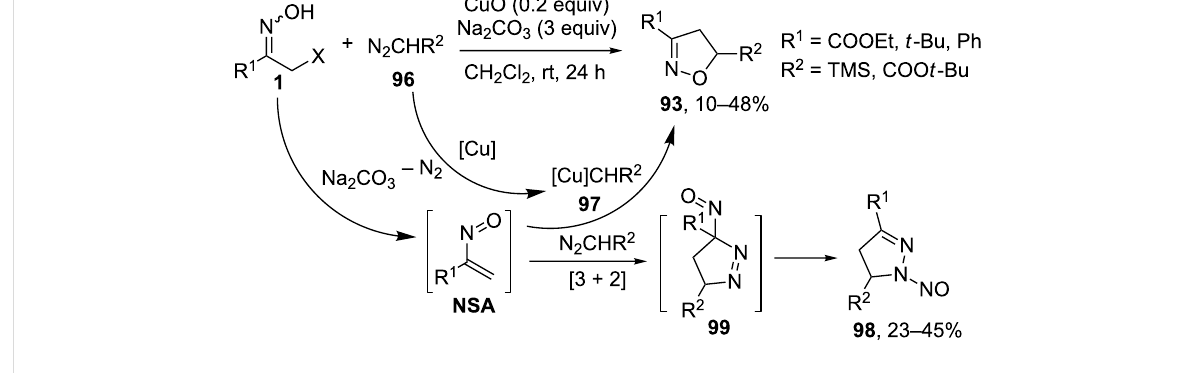
Scheme 36: Reaction of diazo compounds 96 with nitrosoalkenes NSA .